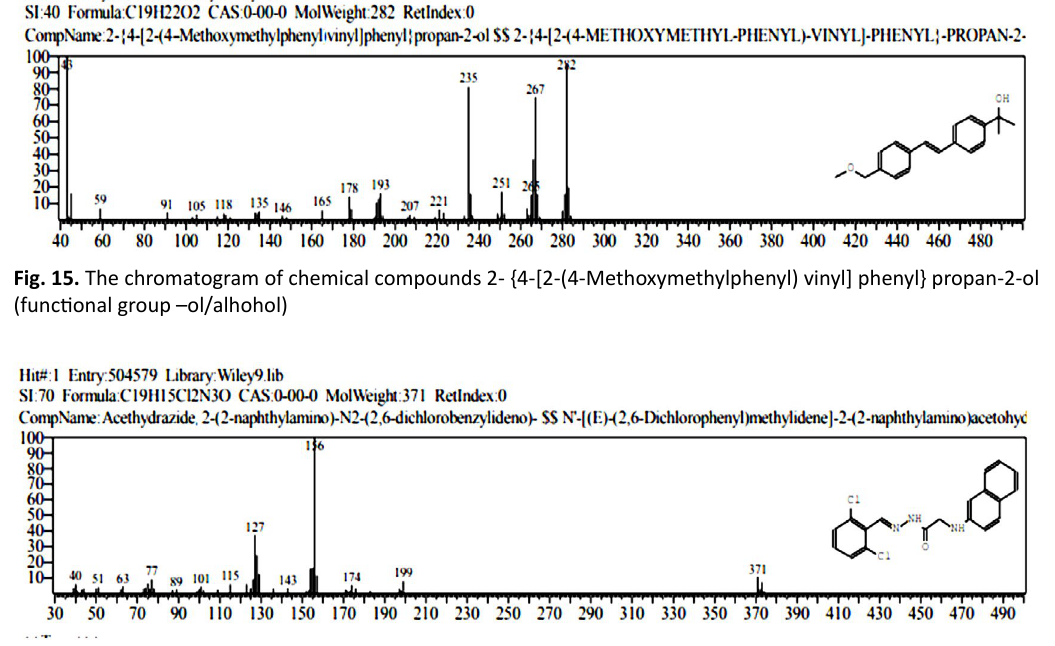
Fig. 16. The chromatogram of chemical compounds Acethydrazide compound, 2- (2-naphthylamino) - N2 - (2 , 6 - dichloro